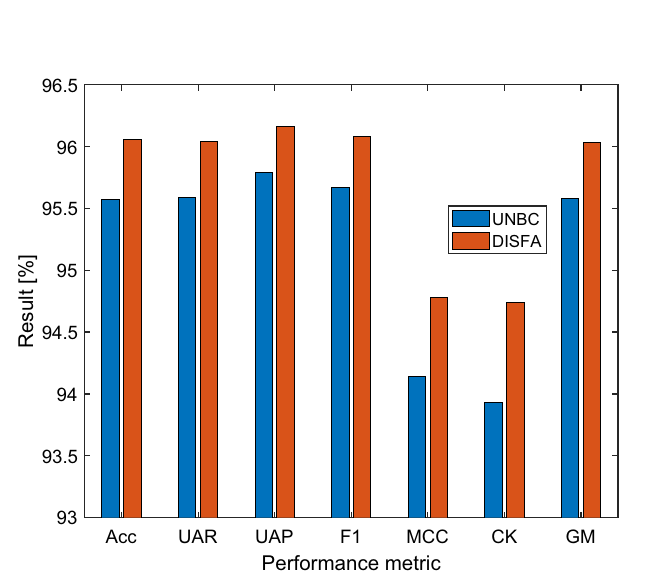
Figure 1. Overall performance comparisons. Acc: accuracy, UAR: unweighted average recall, UAP: unweighted average precision, F1: F1-score, MCC: Matthew’s correlation coefficient, CK: Cohen’s kappa, GM: geometric